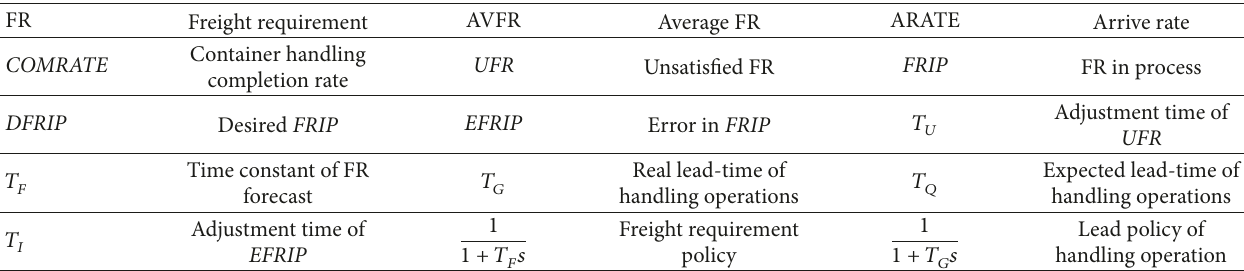
Figure 2: Linear model of handling chain system in container ports. Table 1: Parameters and segments in linear